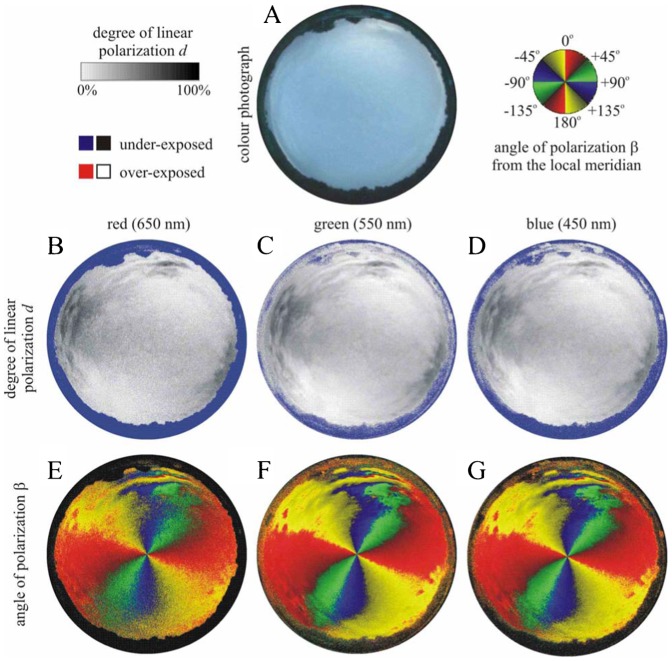
As Fig. 4 for the totally cloudy (overcast) sky no. 357